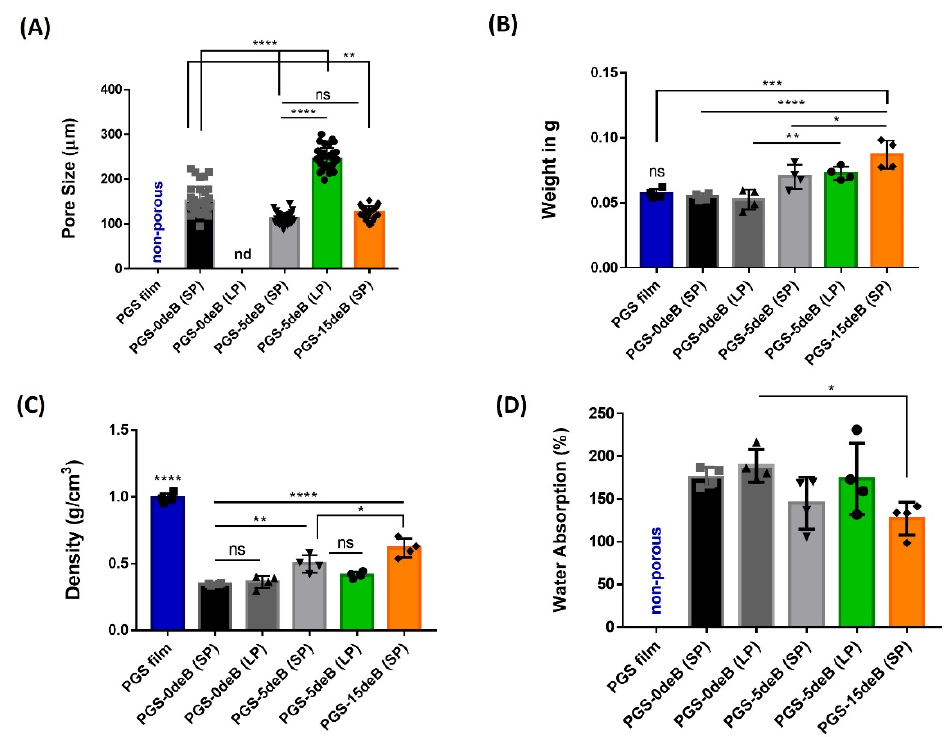
Figure 4. The pore size ( µ m) ( A ), weight (g) ( B ), density (g/cm 3 ) ( C ), and water absorption ( D ) of all PGS-deB blend scaffolds, with small (SP) to large pores (LP), or with varying amounts of bone insertion. * p < 0.05; ** p ≤ 0.01; *** p ≤ 0.001; **** p < 0.0001 indicates significance. Each data have plotted as geometrical symbols on bars. Table 2. Pore size, volume, weight ratios, and porosities of the PGS/deB scaffolds.